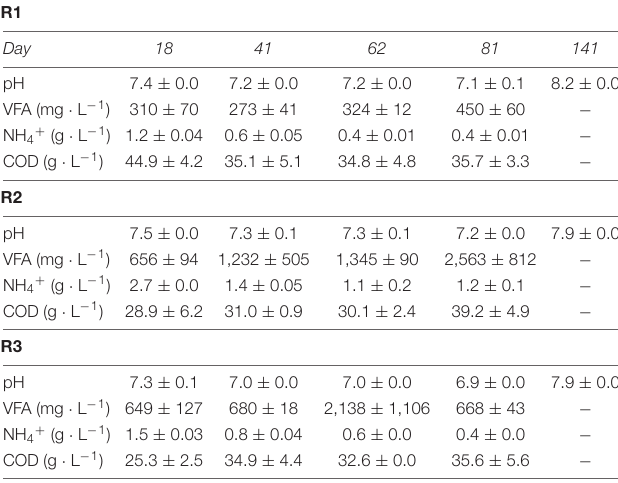
TABLE 2 | Physicochemical parameters of effluent samples from the duplicate lab-scale